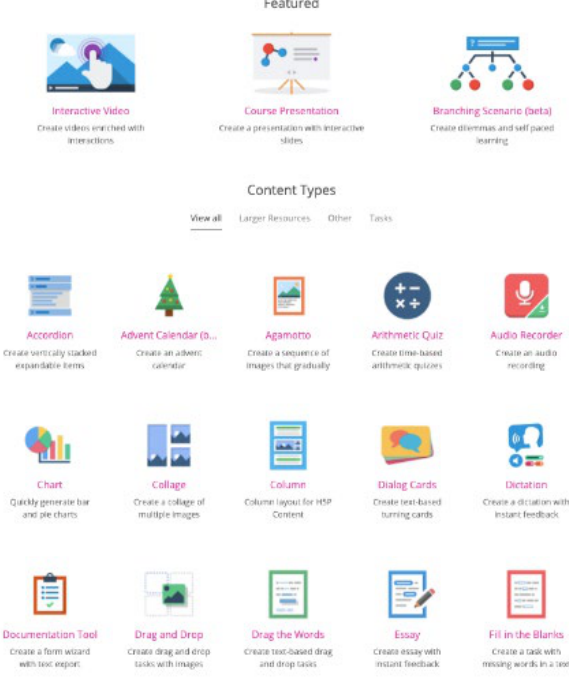
Figure 1 Snapshot of content types, available at